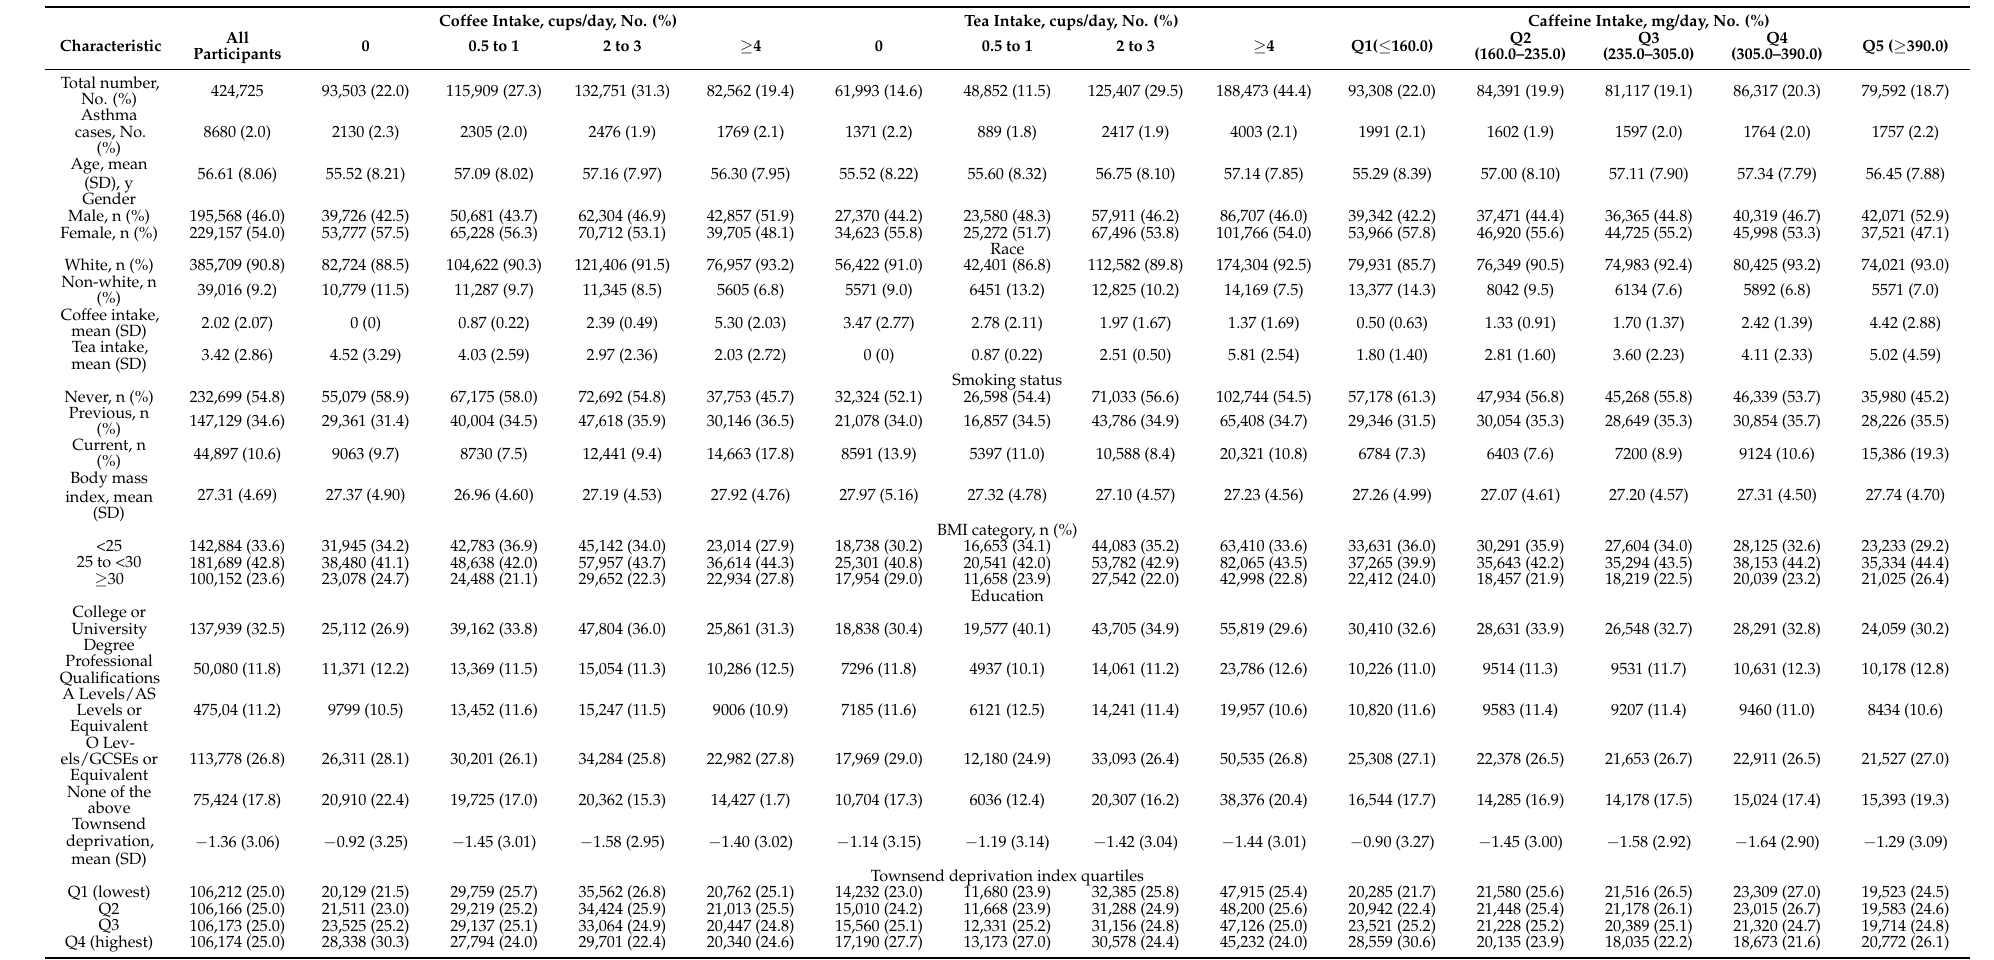
Table 1. Baseline characteristics by coffee and tea intake in the UK Biobank